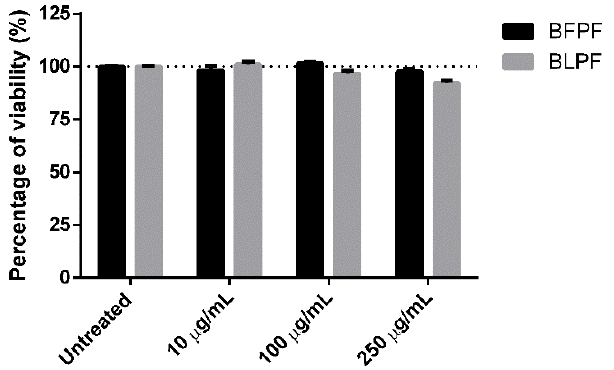
Figure 7. Dose-dependent effect of BFPF and BLPF on cell viability as measured by MTT on R3/1- NF-κB cells. Data are shown as mean ± SEM.